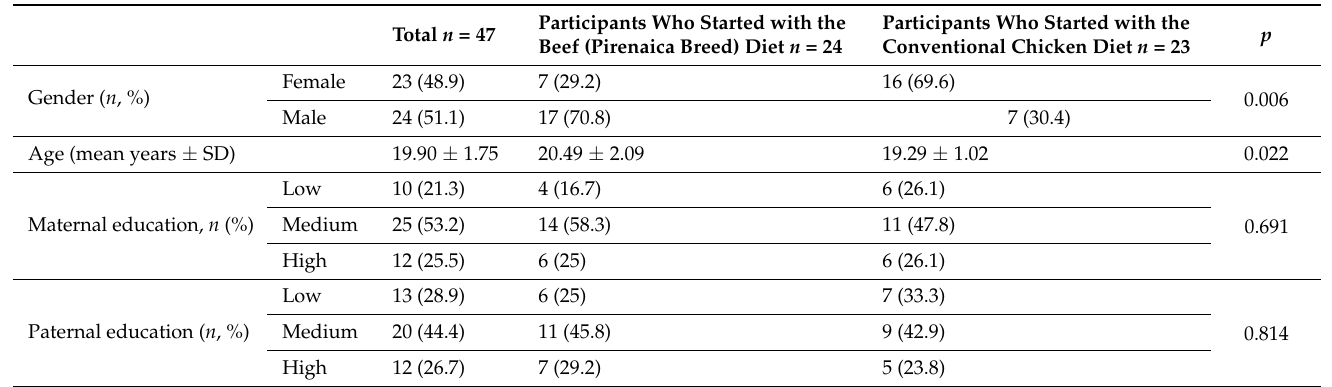
Table 1. Sociodemographic characteristics of included